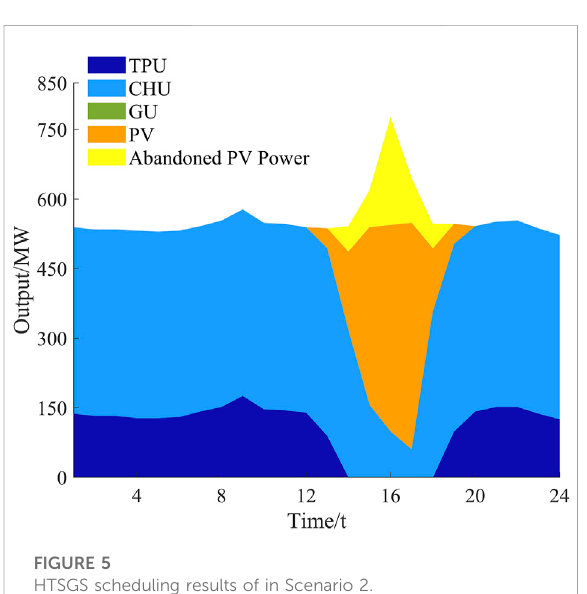
FIGURE 5 HTSGS scheduling results of in Scenario 2.